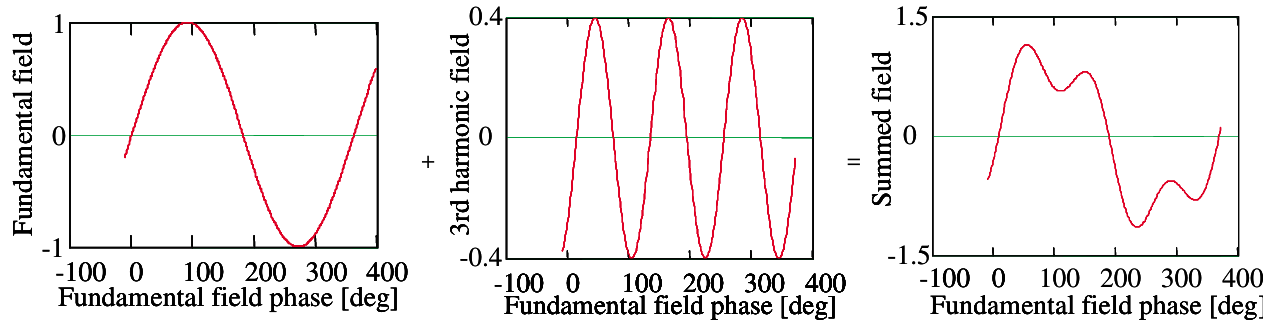
(cid:6) (cid:8) 40 (cid:2) . 3